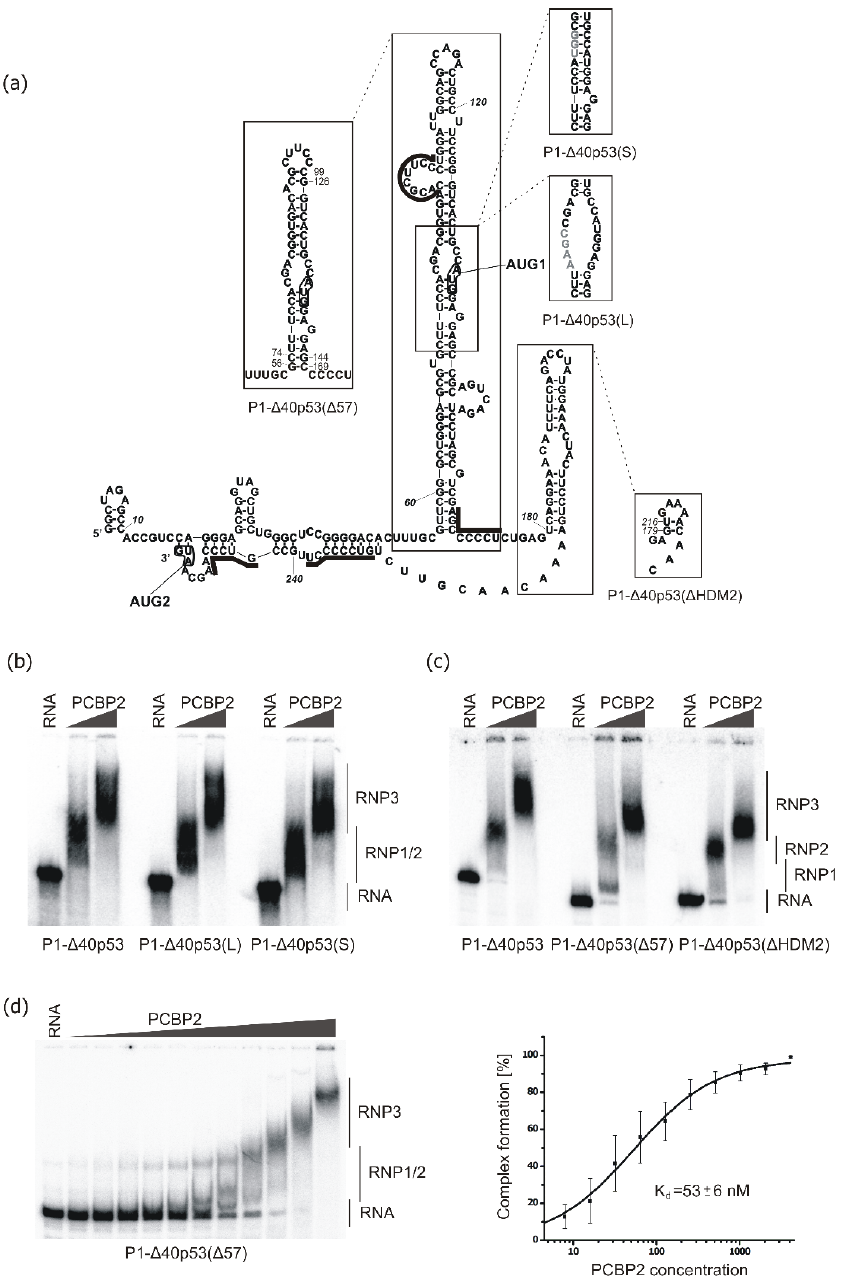
Figure 3. Binding of PCBP2 to the structural variants of the 5 ′ -terminal region of p53 mRNA in vitro. ( a ) Structural variants of P1- Δ 40p53 RNA: P1- Δ 40p53(L)—with an internal loop in which AUG1 is located, P1- Δ 40p53(S)—with a base-paired region in which AUG1 in embedded, P1- Δ 40p53( Δ 57) — with shortened hairpin domain and P1- Δ 40p53( Δ HDM2)—with excised HDM2-binding hairpin. ( b and c ) EMSA assays for the constructs: P1- Δ 40p53, P1- Δ 40p53(L), P1- Δ 40p53(S), P1- Δ 40p53( Δ 57) and P1- Δ 40p53( Δ HDM2). The EMSA was performed by incubating [32P]-labelled RNAs with two concentrations of PCBP2: 1000 nM and 2500 nM at 4 °C for 25 minutes. The samples were separated on native 4% polyacrylamide gels. The first lane in each EMSA panel represents the RNA oligomer incubated without the protein. Unbound RNAs and RNP complexes are indicated. ( d ) Analysis of the complex formation of P1- Δ 40p53( Δ 57) with increased concentrations of PCBP2 (left panel; concentrations of PCBP2 were the same as specified in the legend to Figure 2). Graphs representing dissociation constant (Kd) curves of PCBP2 binding to P1- Δ 40p53( Δ 57) RNA, measured from three independent experiments, are also shown (right panel).